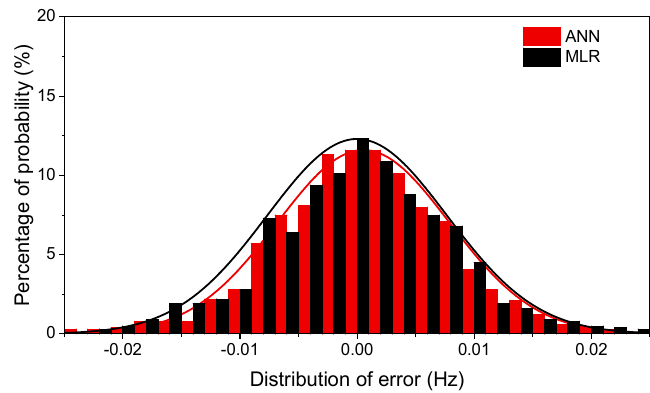
Figure 21. The distribution of error vectors of the ANN and PR models for the 5th model. Table 2. The RMSE of errors produced by the ANN and PR models.